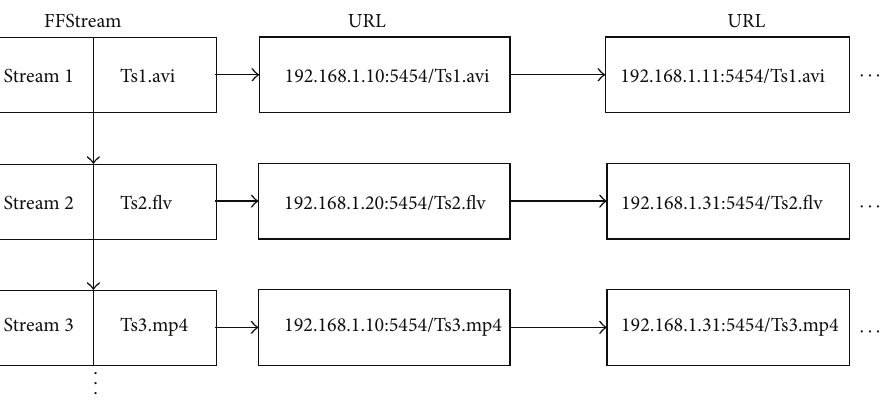
Figure 2: Video streaming list.